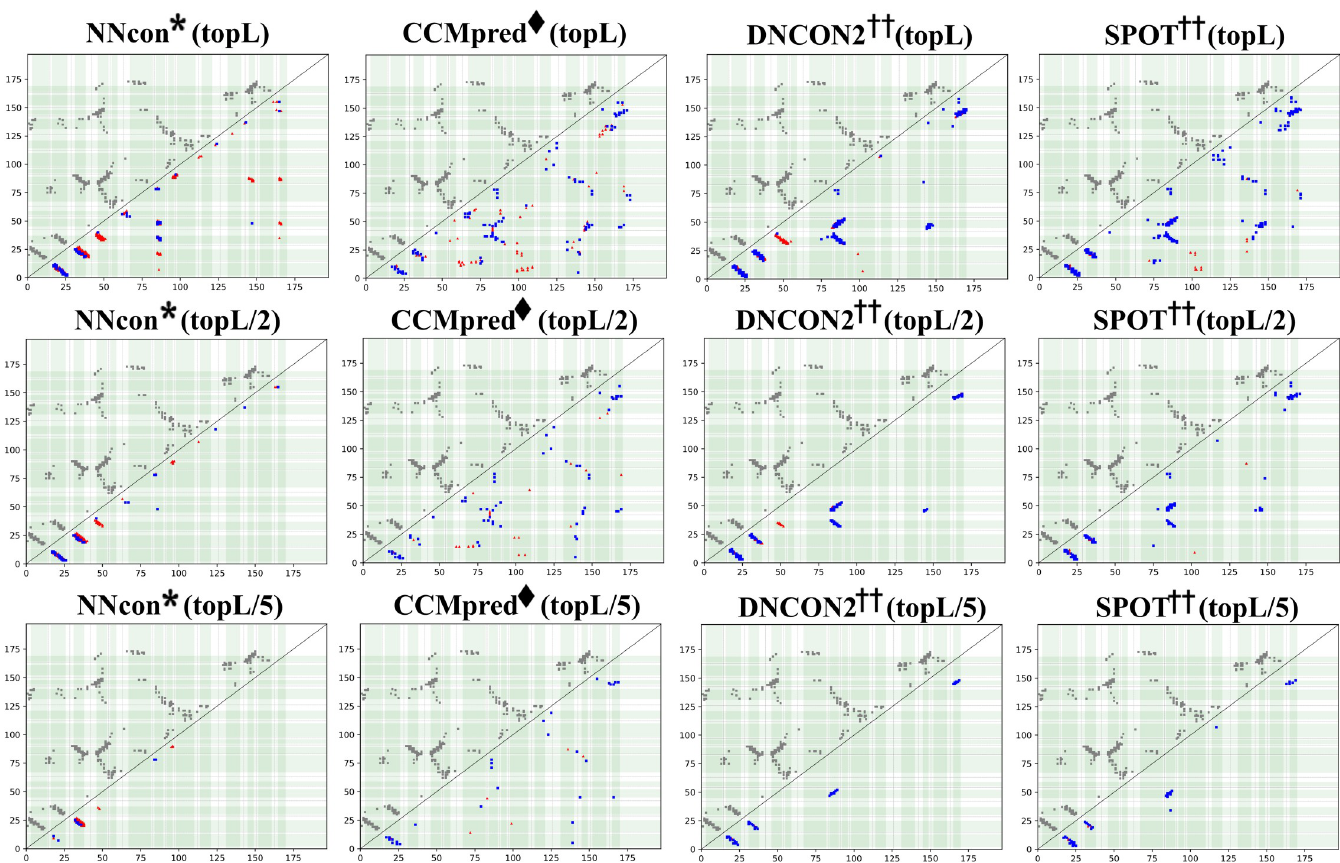
Fig 9. Residue contact map of 2BZ1A by NNcon/ CCMpred/ DNCON2/ SPOT for top L, L/2 and L/5 predictions. Gray squares in the left upper part are the contacts in native structures, blue squares in the right lower part is the correctly predicted contacts and red triangles are wrongly predicted contacts. Regions are divided by the black dashed lines centered with light green secondary structures. When a limited number of top predictions are considered, the predictions by DL methods cover fewer regions, but are more accurate in overall performance and contact pattern recognition.